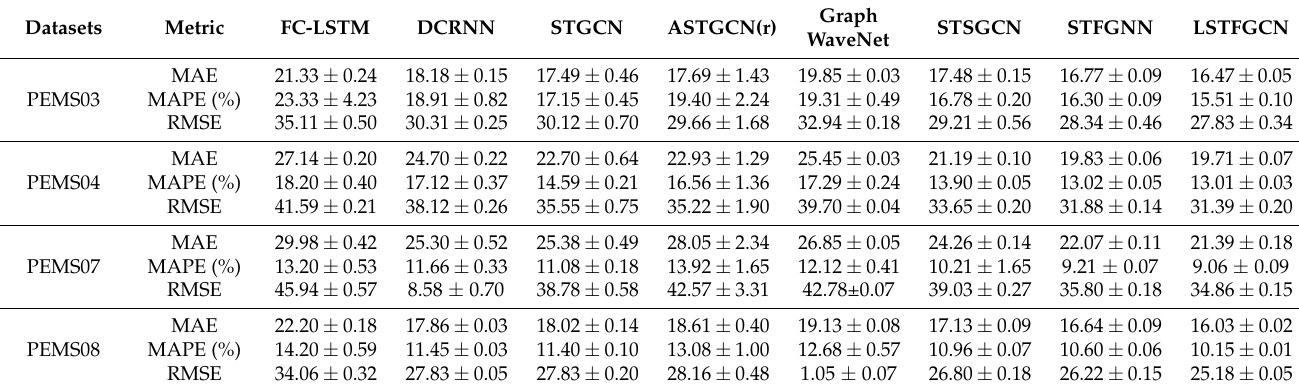
Table 2. Performance comparison of LSTFGCN and baseline models on PEMS03, PEMS04, PEMS07 and PEMS08 datasets.